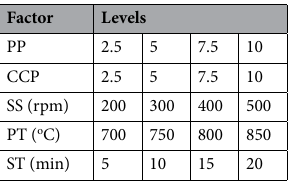
Table 1. Factor and Levels of the Stir Casting Process Parameters.